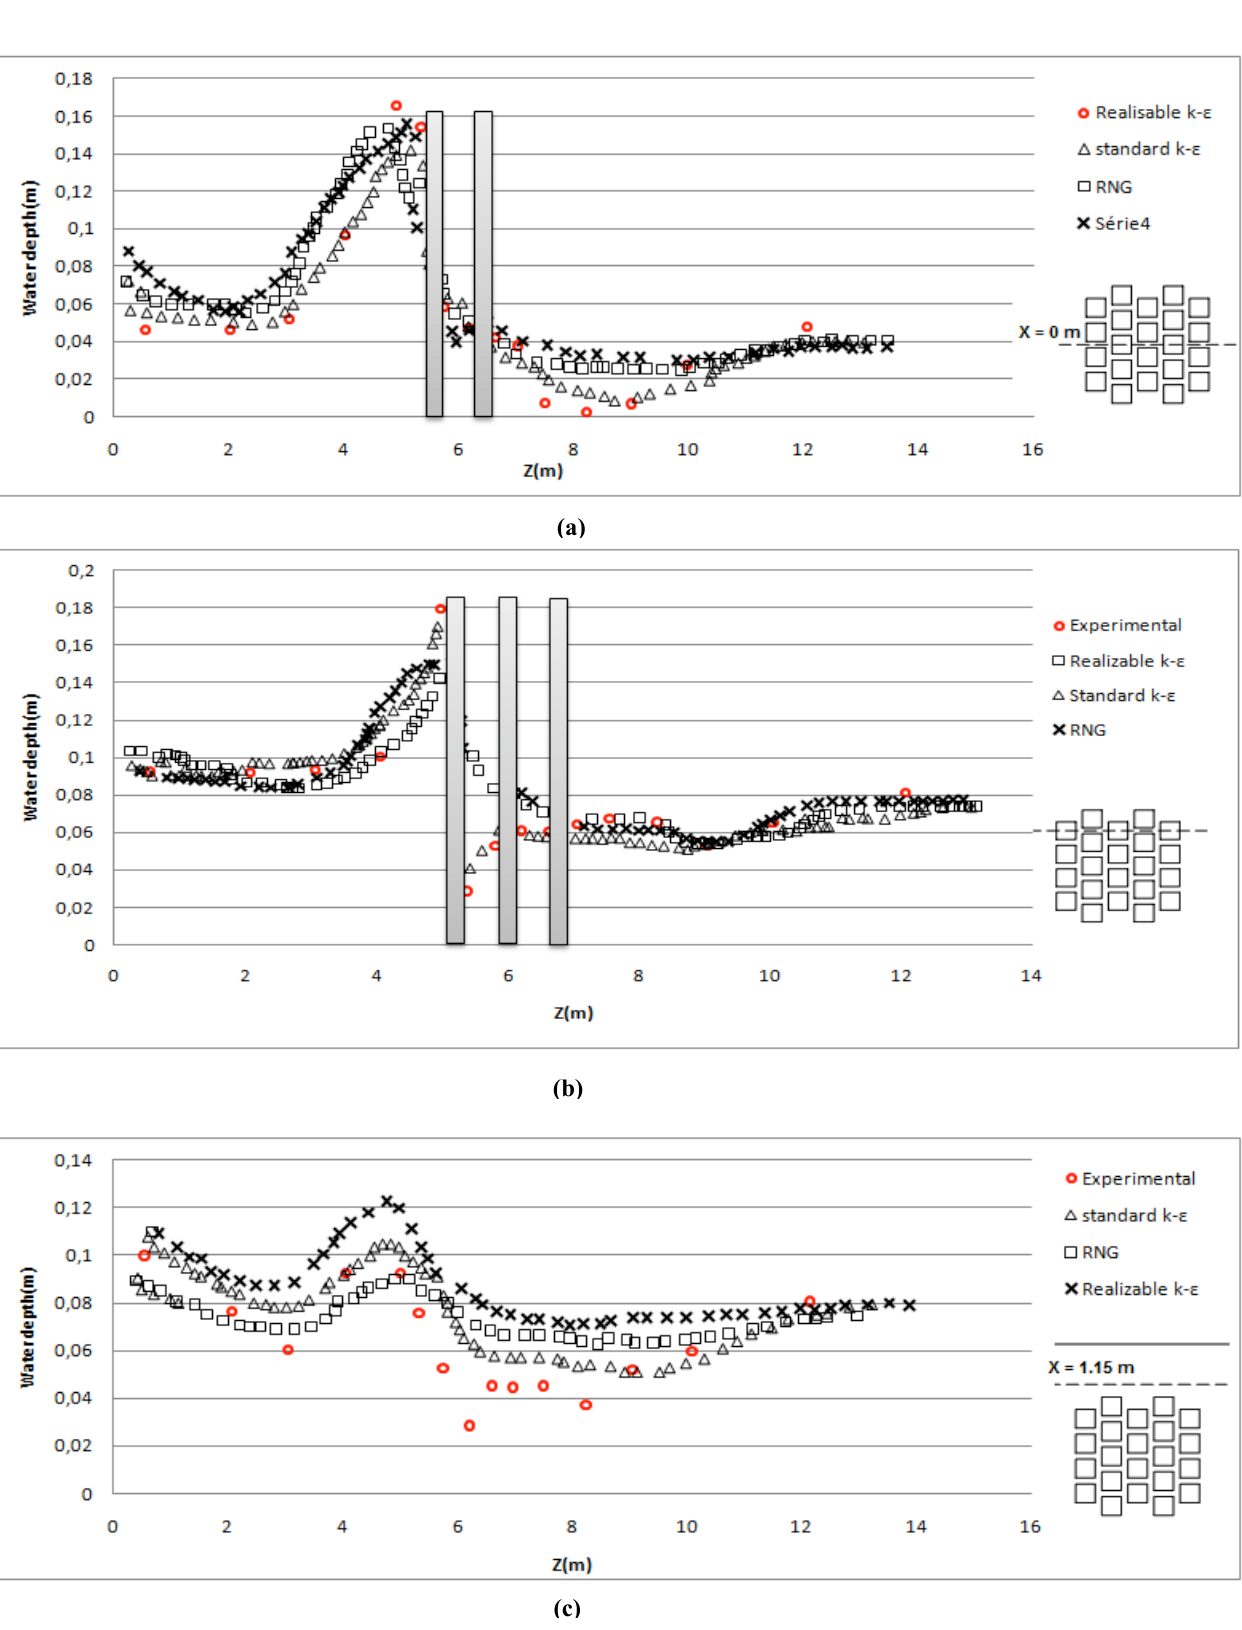
Fig. 12. Profiles along the free surface for the three turbulence models along the axis X. (a) For X = 0 m, (b) For X = 0.6m and (c) For X =